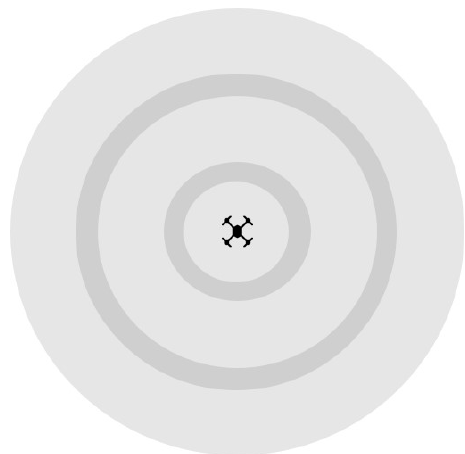
Figure 3. Schematic diagram of the monitoring area that can be photographed through the point count survey method. The concentric gray circles represent image acquisition areas, and the dark gray part is the overlapping area.